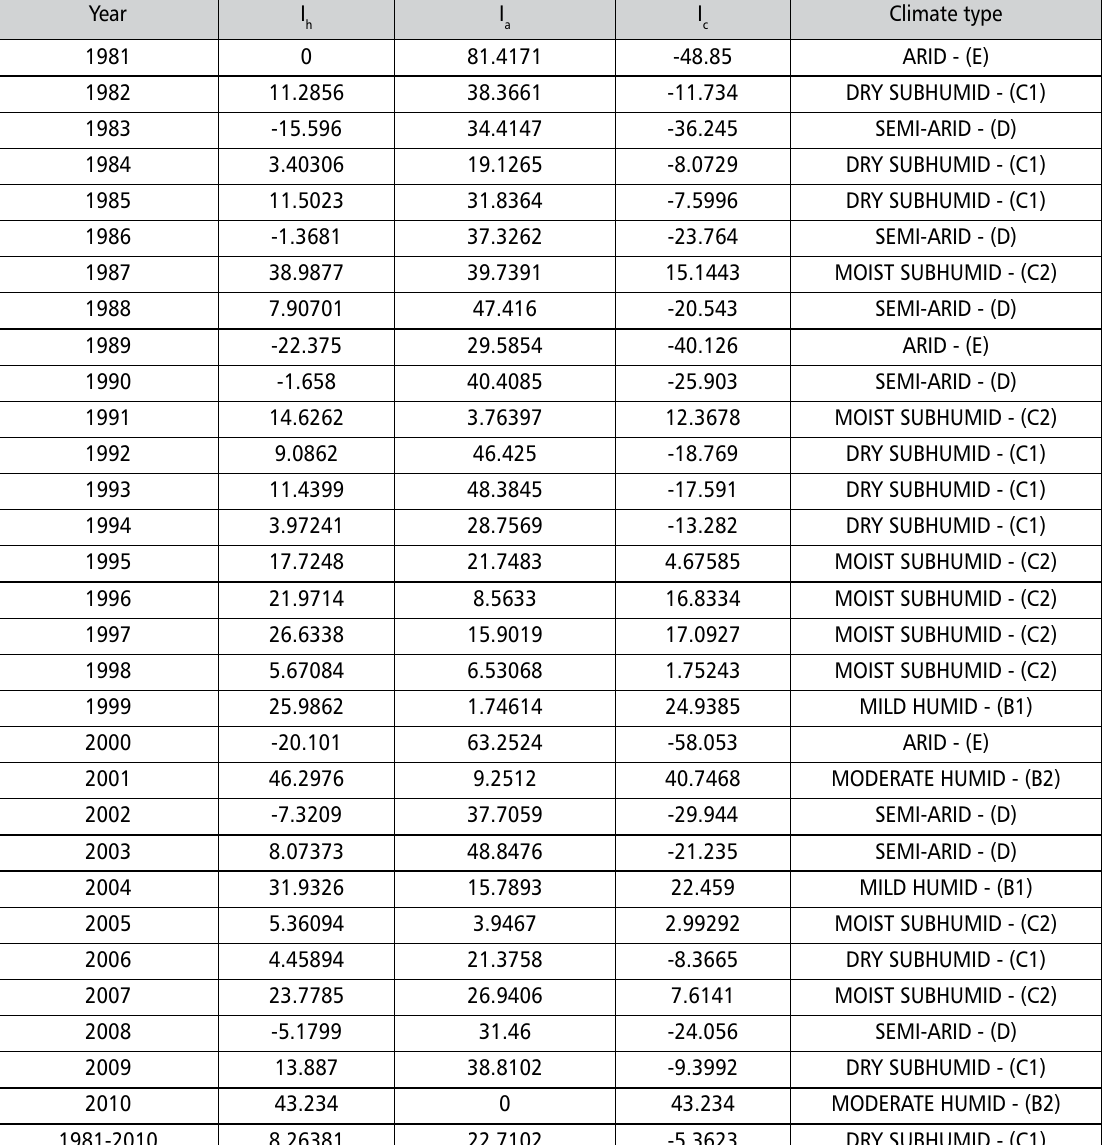
Humidity index (I ), aridity index (I ), climate index (I ) and climate types determined by using Thornthwaite’s h a c method for the weather station Rimski Šančevi,